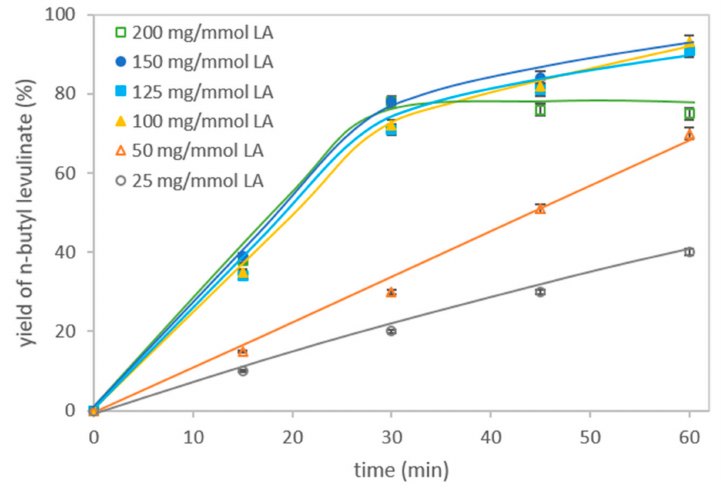
Figure 3. The effect of amount of CALB/MWCNT-PTFE on LA esterification. Reaction conditions: LA (0.117 g, 1 mmol); n -butanol (0.148 g, 2 mmol); biocatalyst CALB/MWCNT-PTFE (0.1 wt.%) (25–200 mg); n -hexane (1 mL); 20 ◦ C; 250